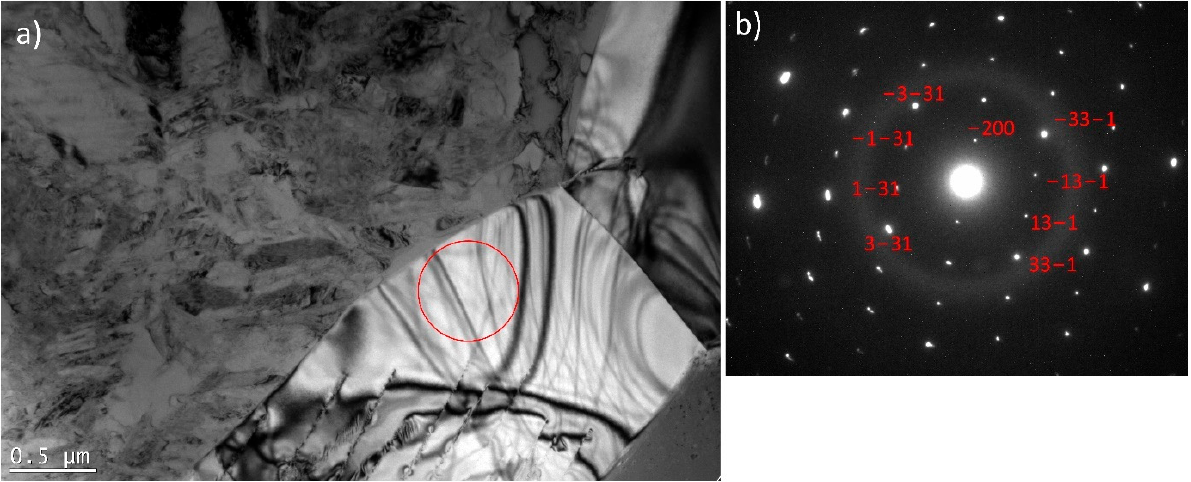
Figure 7. ( a ) A bright-field image of the NiTi matrix; ( b ) with a corresponding SAED pattern from (an area marked by a yellow circle).